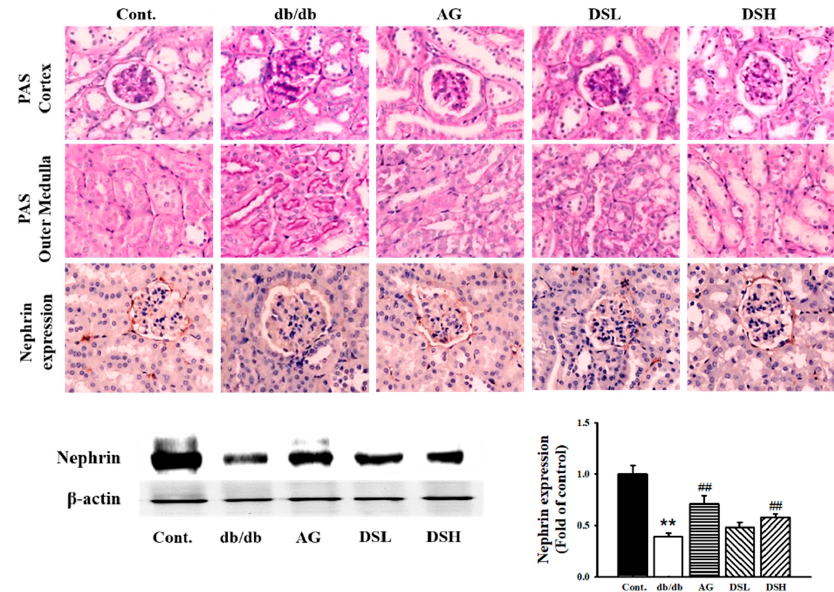
Figure 5. Effect of DS-EA on renal pathological changes and nephrin immunoreactivity in db/db mice. Representative microscopic photographs of a kidney stained with periodic acid-Schiff (PAS). Kidney sections in the cortex (glomerulus) and outer medulla were obtained from the db/m (Cont.) group, db/db (db/db) group, aminoguanidine-treated db/db group (AG), DS-EA